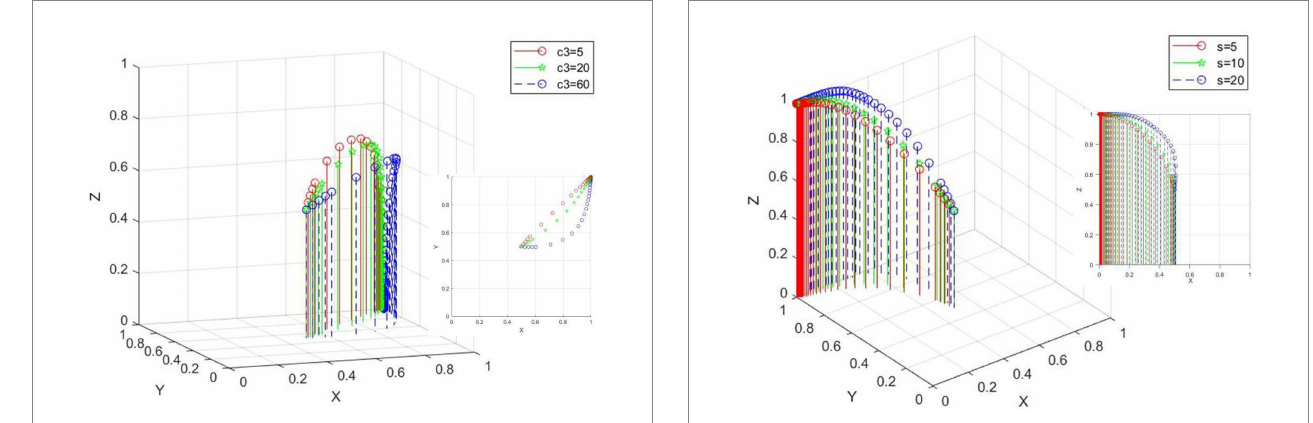
FIGURE 3 Impact diagram of rent-seeking costs (Scenario 1).